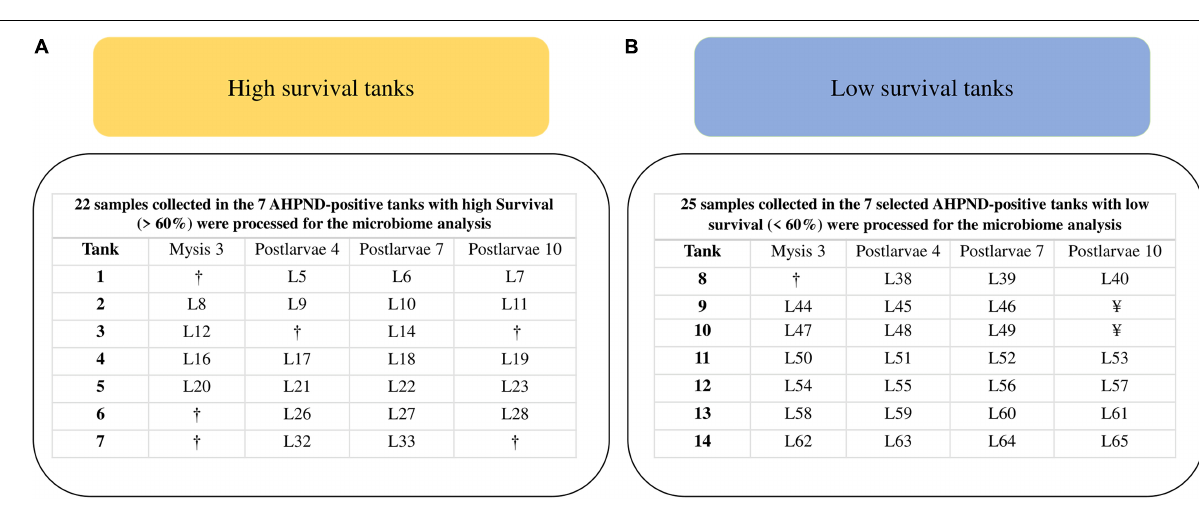
( Figure 1 ). The null hypothesis of equal microbiomes between the high- and low-survival tanks was evaluated by the analysis of similarities (ANOSIM) at each larval